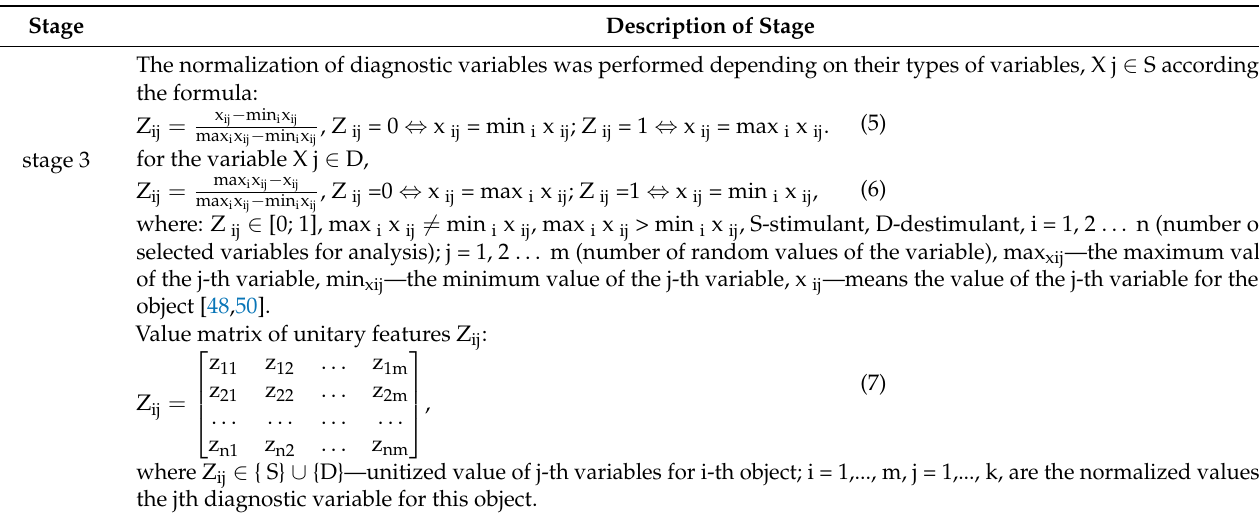
Table 3. The stages 3 of building a synthetic measure. Description of